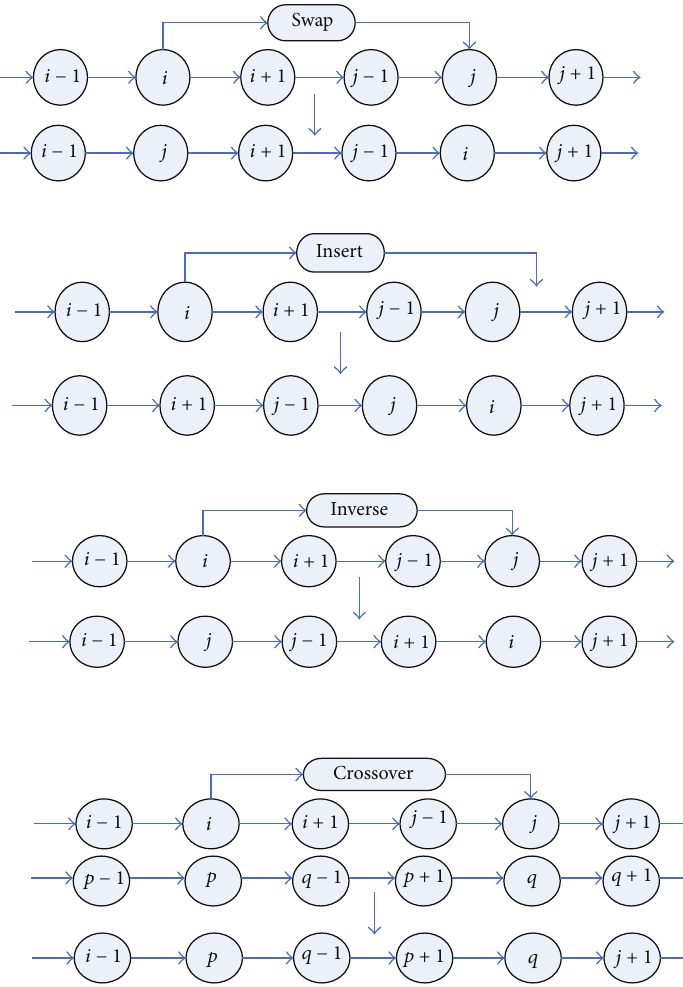
Figure 1: Four neighborhood operations (swap, insert, inverse, and